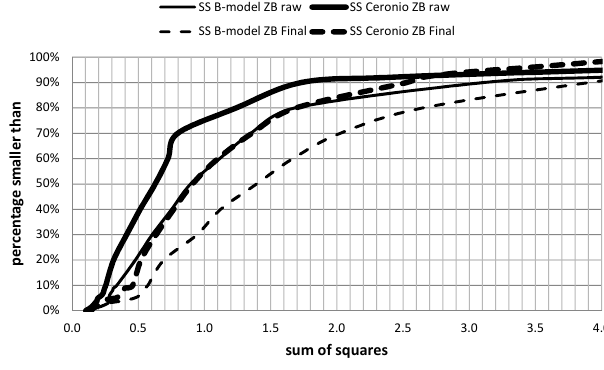
Figure 2. Cumulative sum of square for the ZB treatment plant.